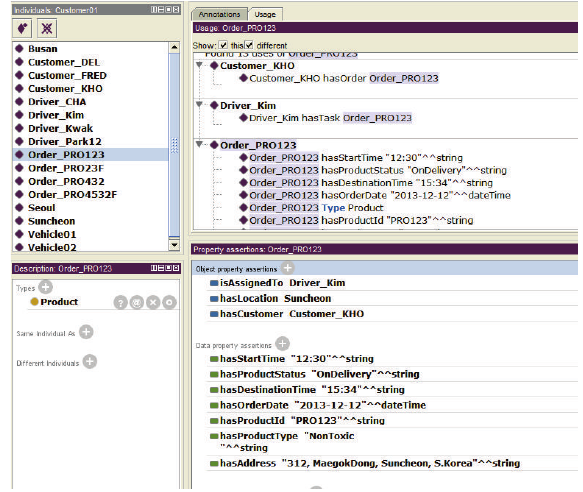
Figure 10: Instantiation of logistics